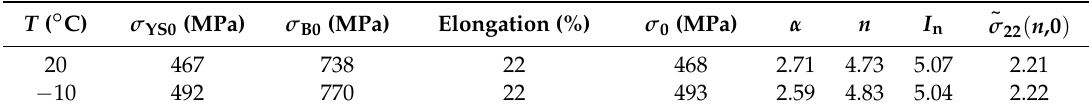
Table 4. Mechanical properties, Ramberg–Osgood parameters, and related parameters ( I n and (cid:101) σ 22 ( n ,0 ) ) for S45C. Here, σ YS0 and σ B0 are nominal yield and tensile stresses, respectively.